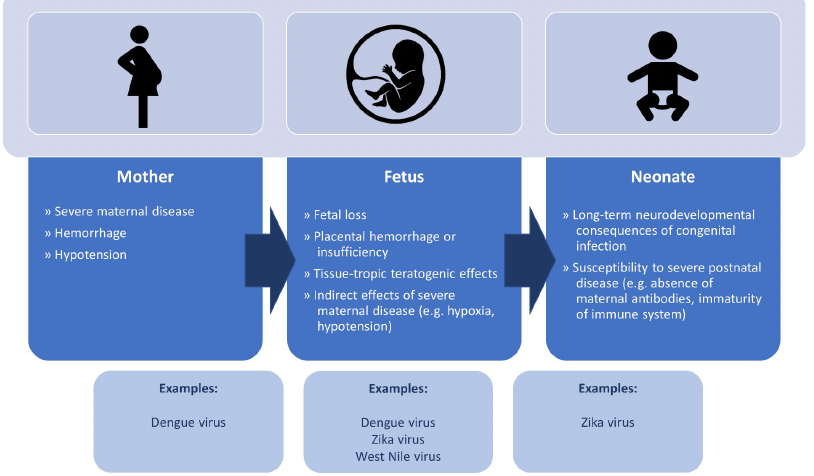
Figure 2. Pathophysiological impacts of flavivirus infection on the pregnant mother, fetus, and ne- onate.